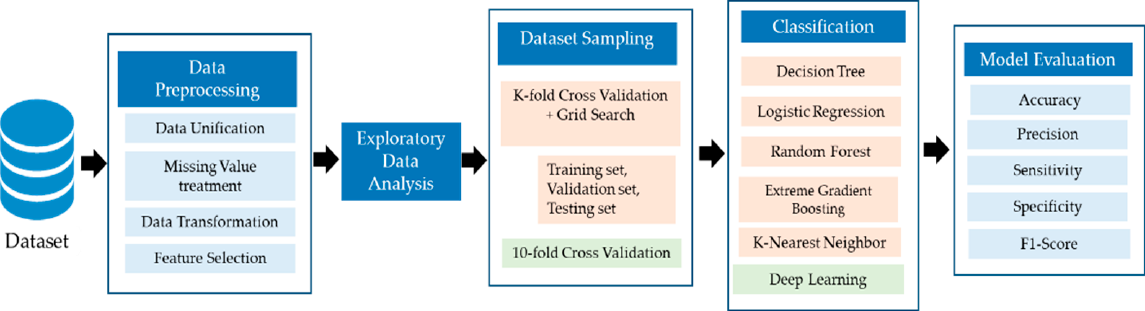
Figure 1. Framework of the proposed study.